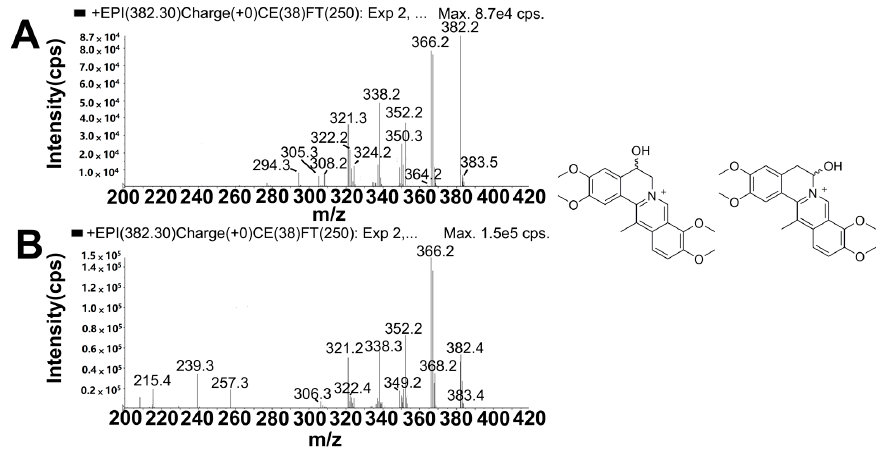
Figure 6. The mass spectrometry (MS 2 ) spectra of hydroxylated metabolites ( A : M11; B : M12, M13 and M14).